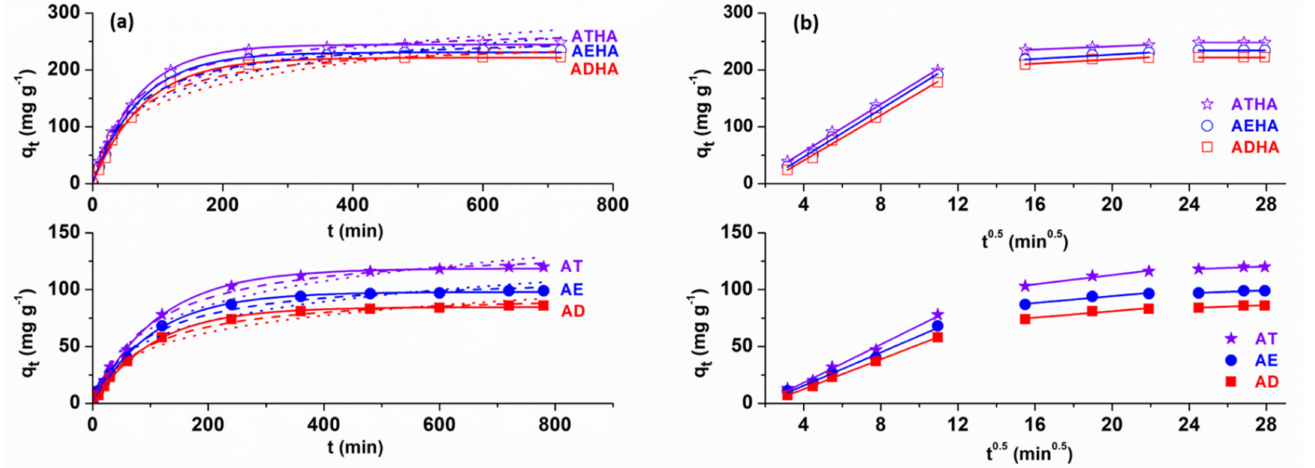
Figure 14. Lagergren (solid line), Ho (dash line), Elovich (dot line) models ( a ) and Weber–Morris intraparticle diffusion model ( b ) for metronidazole adsorption on precursor/hybrid microparticles (C metronidazole = 1 × 10 − 3 g · mL − 1 , T = 35 ◦ C). The kinetic parameters obtained from the Lagergren, Ho, Elovich and Weber–Morris models are presented in Tables 10 and